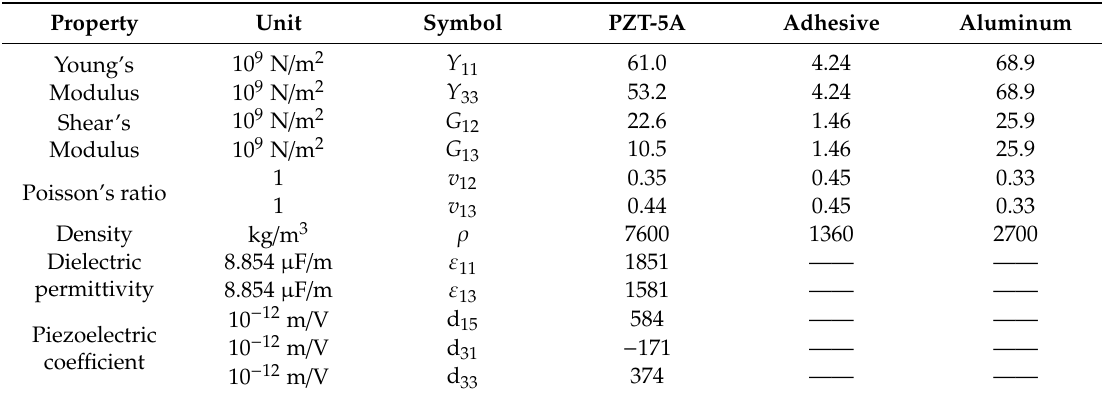
Table 1. Material properties of the shear-mode piezoelectric transducer, Hysol EA9394, and Aluminum 6061 [16].